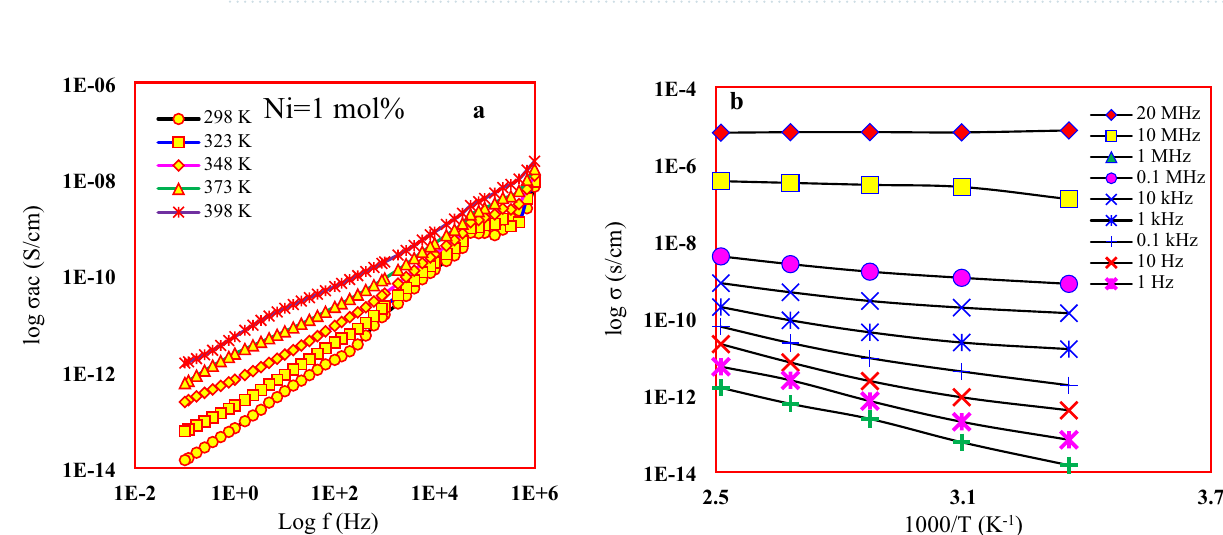
Figure 7. Ac conductivity dependence on ( a ) Frequency and ( b ) Temperature for the considered